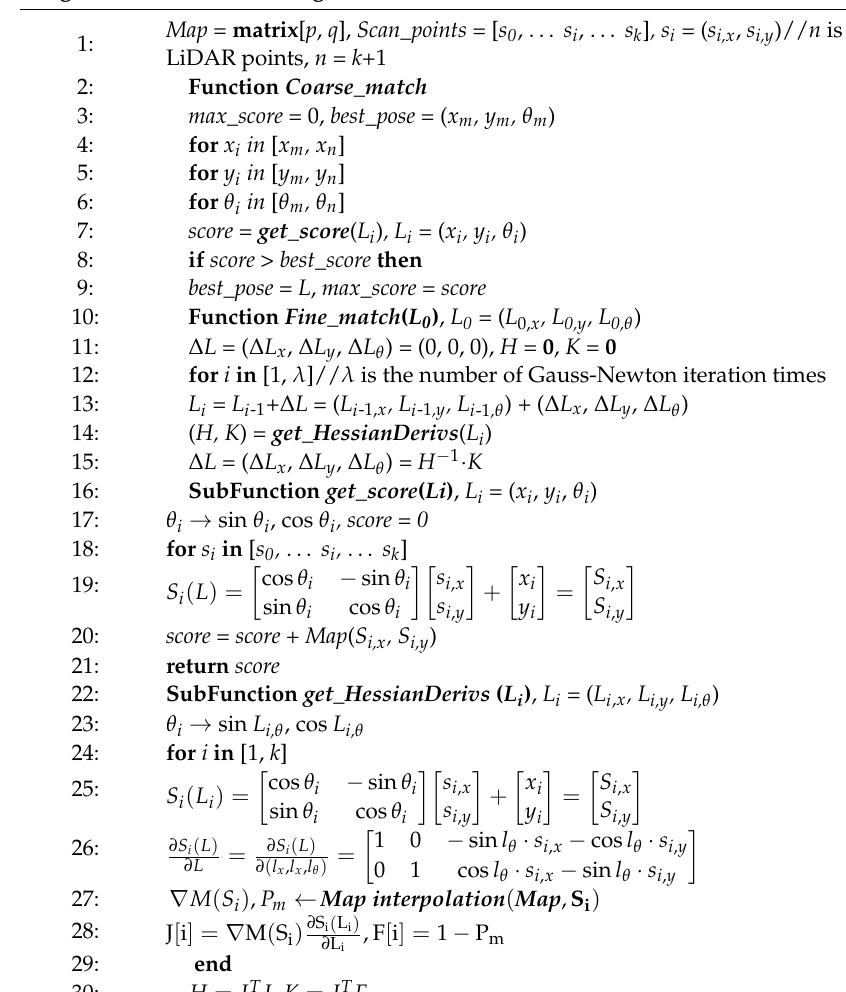
Algorithm 2: NLO-CSM